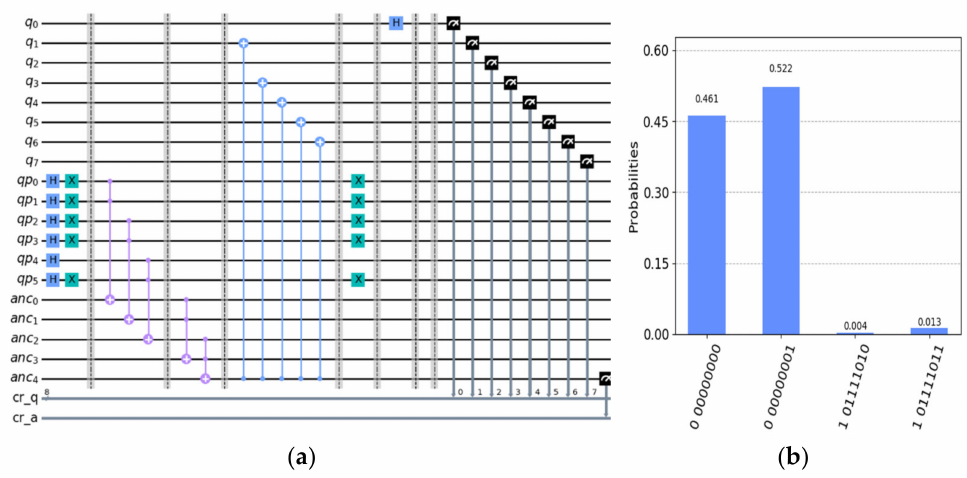
Figure 6. ( a ) The NEQR representation for the third pixel (gray level 122, LSB set to 0) and ( b ) the measurement results.